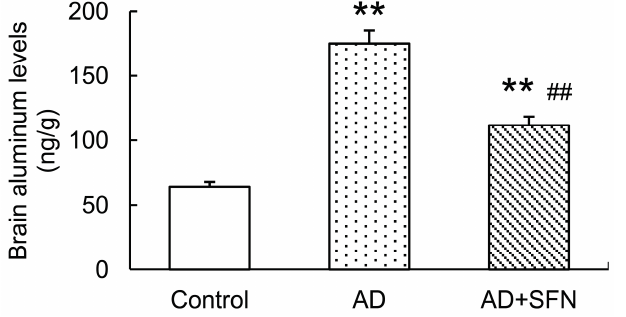
Figure 2. Analysis of aluminum level in the mouse brain. Brain aluminum levels were significantly higher in AD-like mice and AD + SFN-like mice than in controls; AD-like mice with sulforaphane treatment exhibited lower brain aluminum levels than AD-like mice without sulforaphane treatment. ( n = 10; means ± S.E.M.; One-way analysis of variance followed by post hoc least significant difference multiple comparison tests; ** p < 0.01 versus control, ## p < 0.01 versus